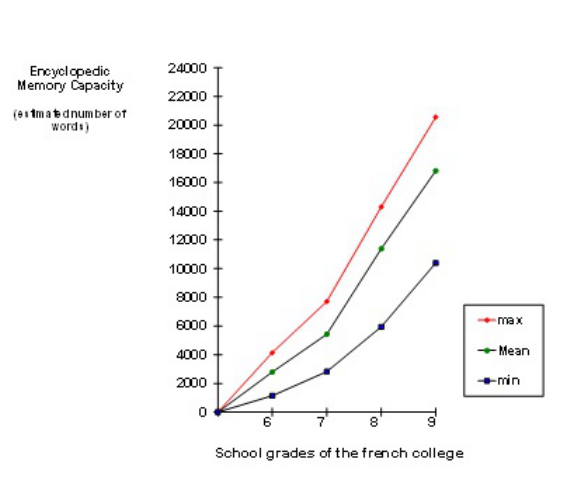
Figure 1. Estimate of encyclopedic storage capacity measured by number of words acquired at the end of year, from grade 6 to grade 9 ofmiddle